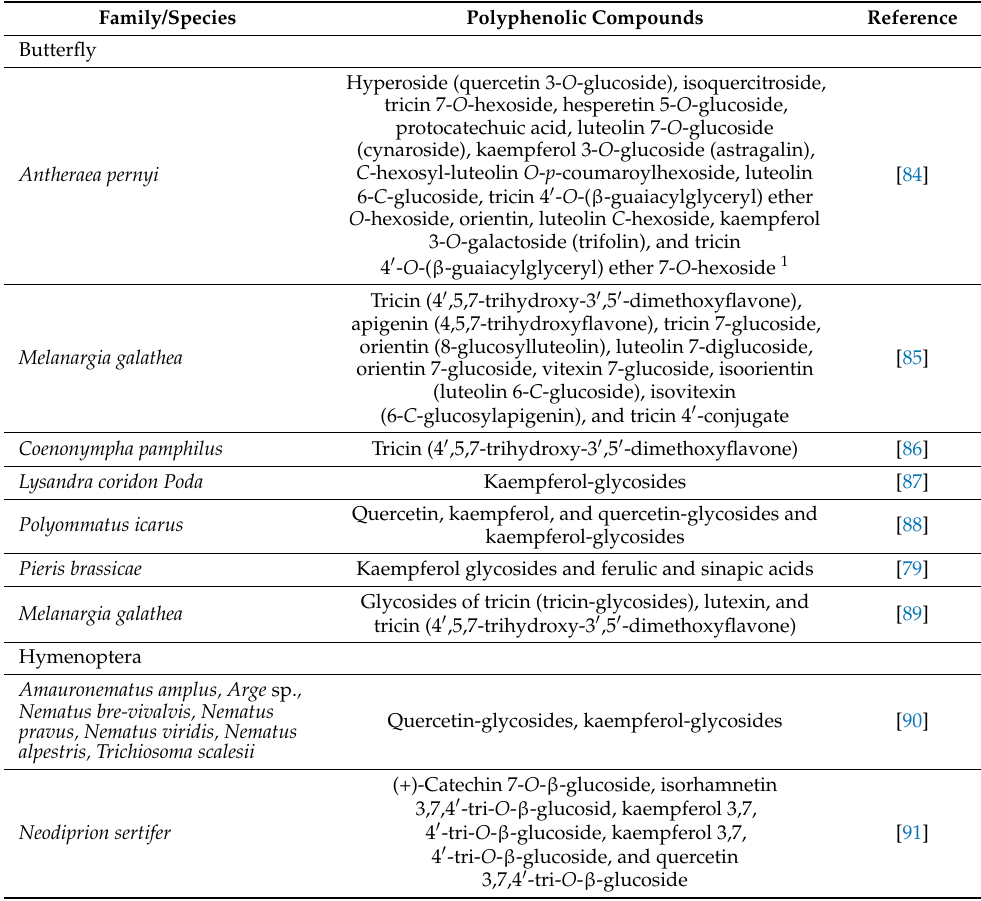
Table 3. Cont. Family/Species Polyphenolic Compounds Reference Butterfly